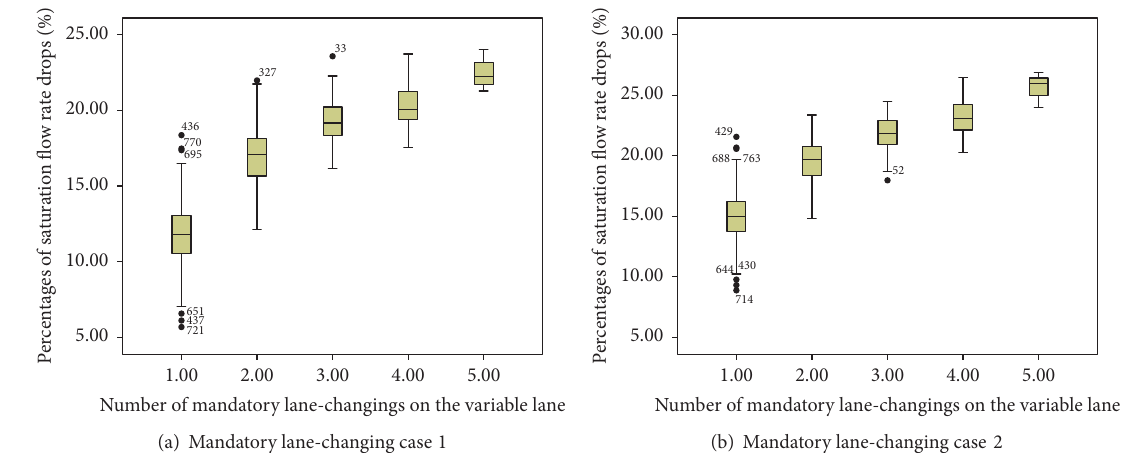
Figure 7: Percentages of saturation flow rate drops under different number of mandatory lane-changings.